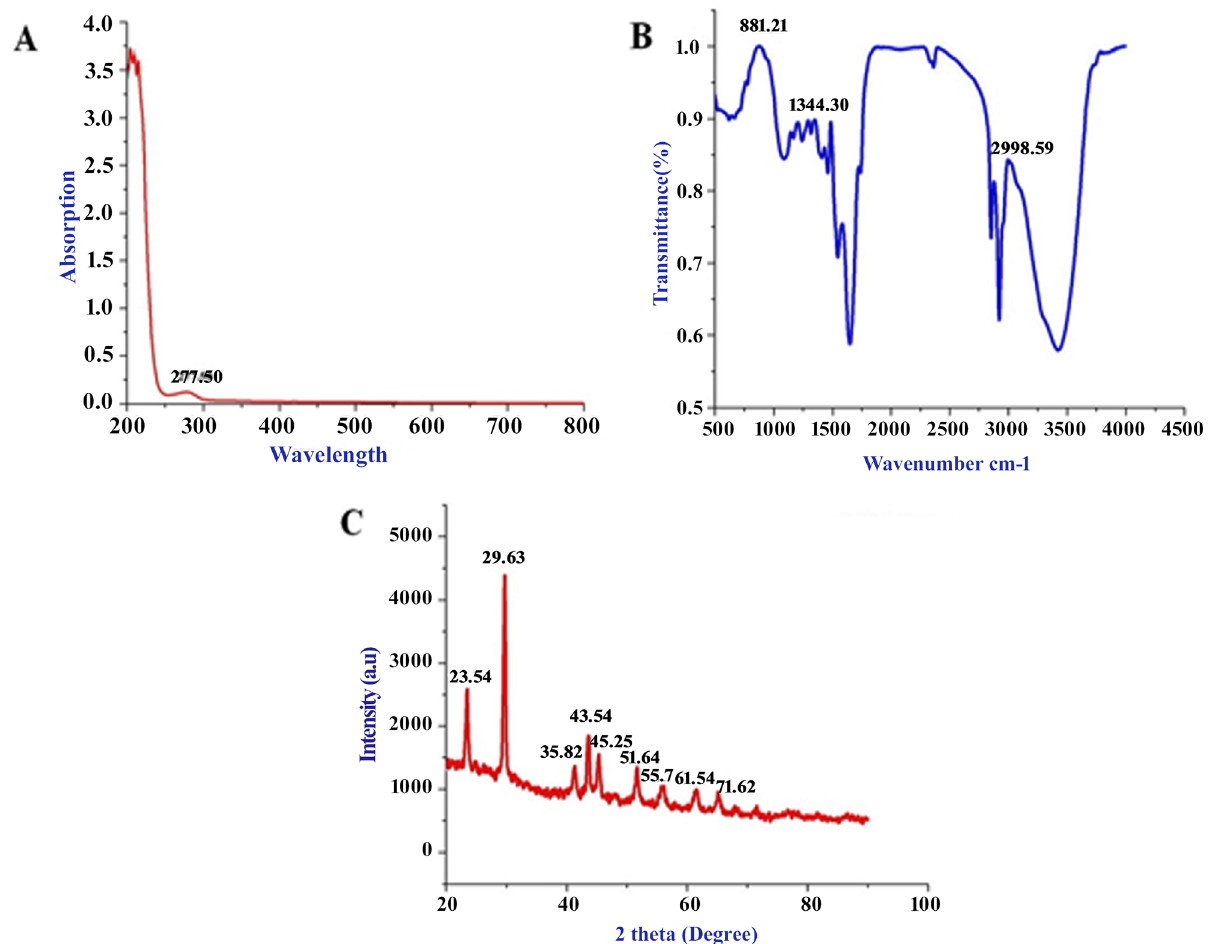
Figure 1. Rapid synthesized SeNPs ( A ) UV–visible absorbance spectrum analysis, ( B ) FT-IR analysis and ( C ) XRD analysis.